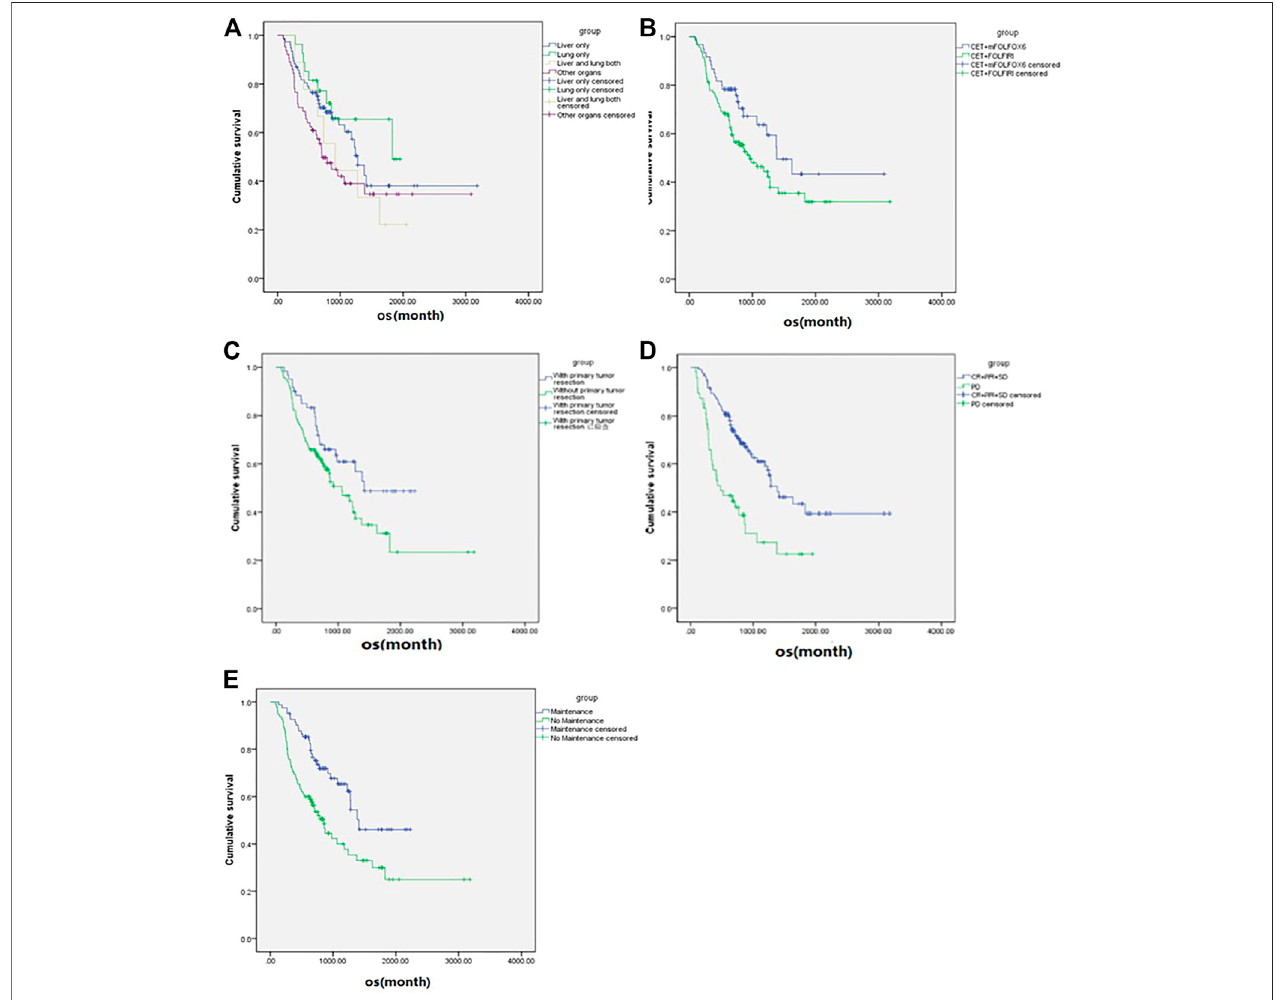
FIGURE2| Subgroupanalysis(accordingtothevariables in Table 3 ) ofoverall survivalofthemetastatic colorectal cancerpatients( n (cid:1) 177). (A) Metastases sites. (B) Chemotherapy regimen. (C) Primary tumor resection. (D) Best overall response. (E) Maintenance or not.